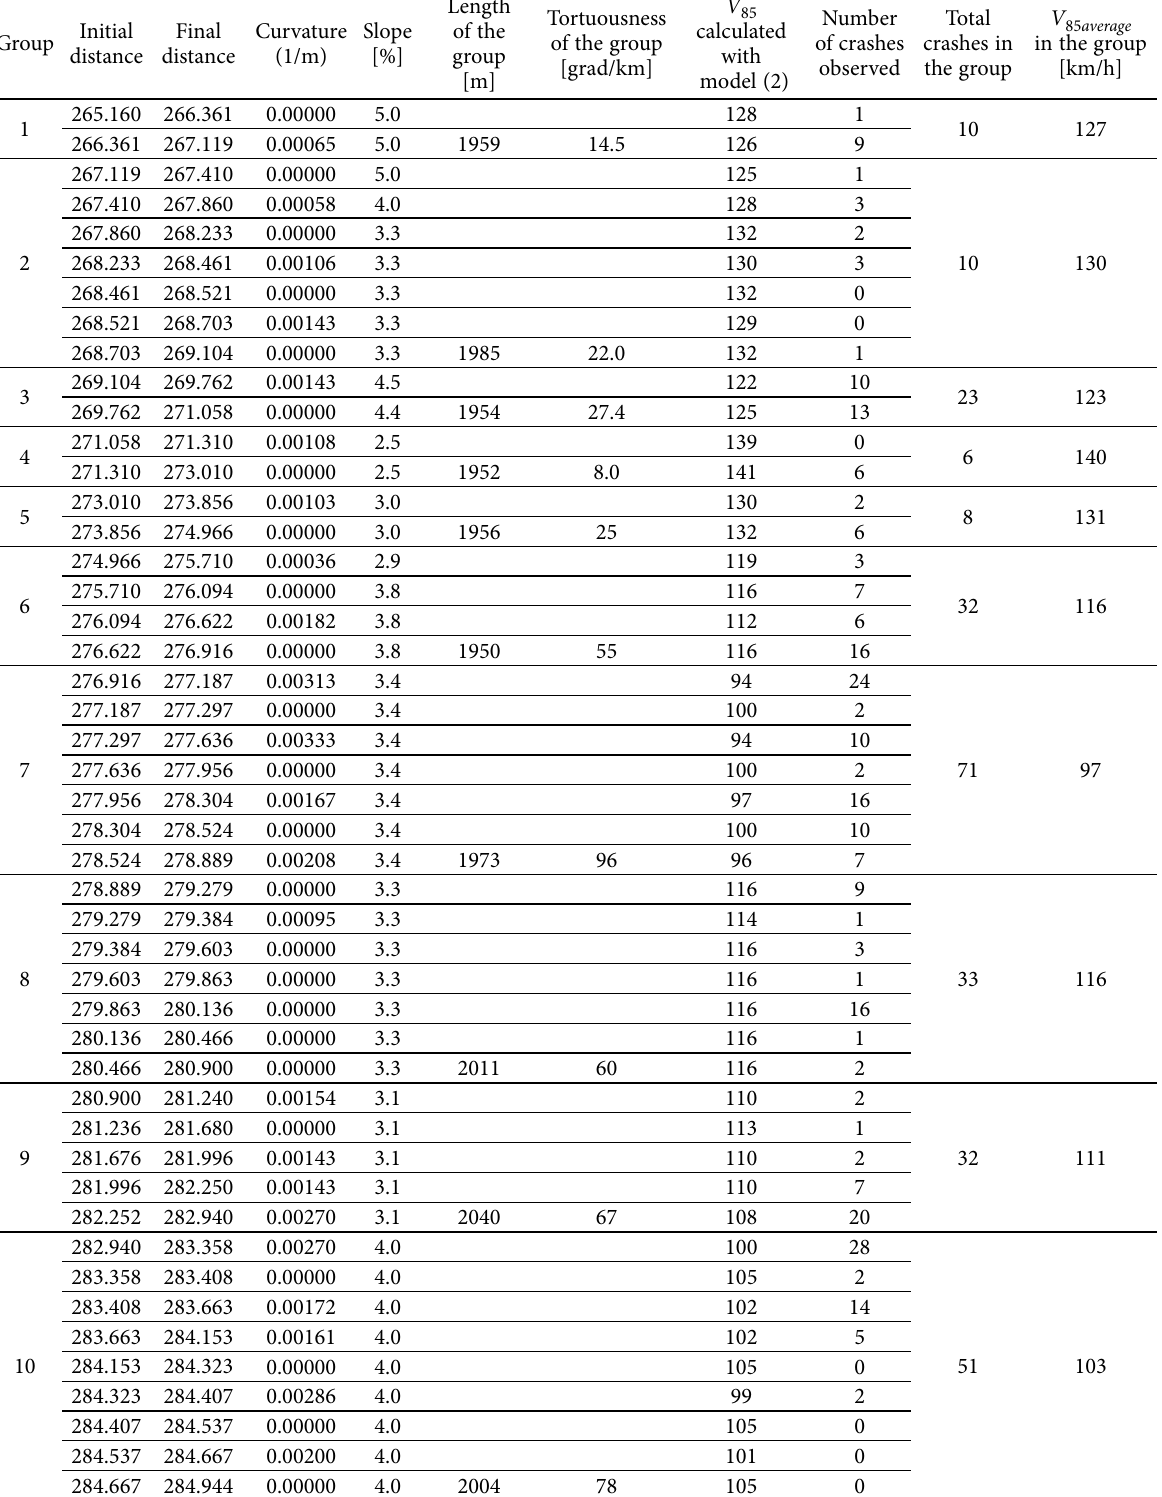
Table 6. ‘t-student’ test, model